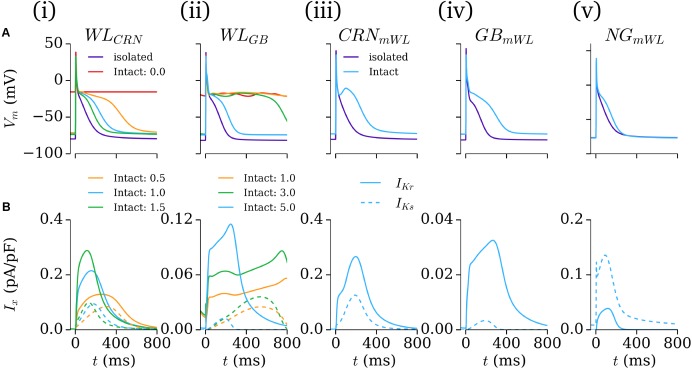
Intact-cell models. (A) AP and (B)
IKr and IKs current traces for the five model variants (i–v) under isolated and intact conditions. For panels (i,ii), colors correspond to the isolated-cell model (purple), intact-cell model without introduction of IKr and IKs (red), and introduction of a small amount of each current (orange, green, blue). The scale factors for the WLCRN and WLGB models are indicated in their respective panels. In iii–v, just the isolated (purple) and intact (blue) variants are shown. In B, solid lines refer to IKr and dotted lines to IKs.